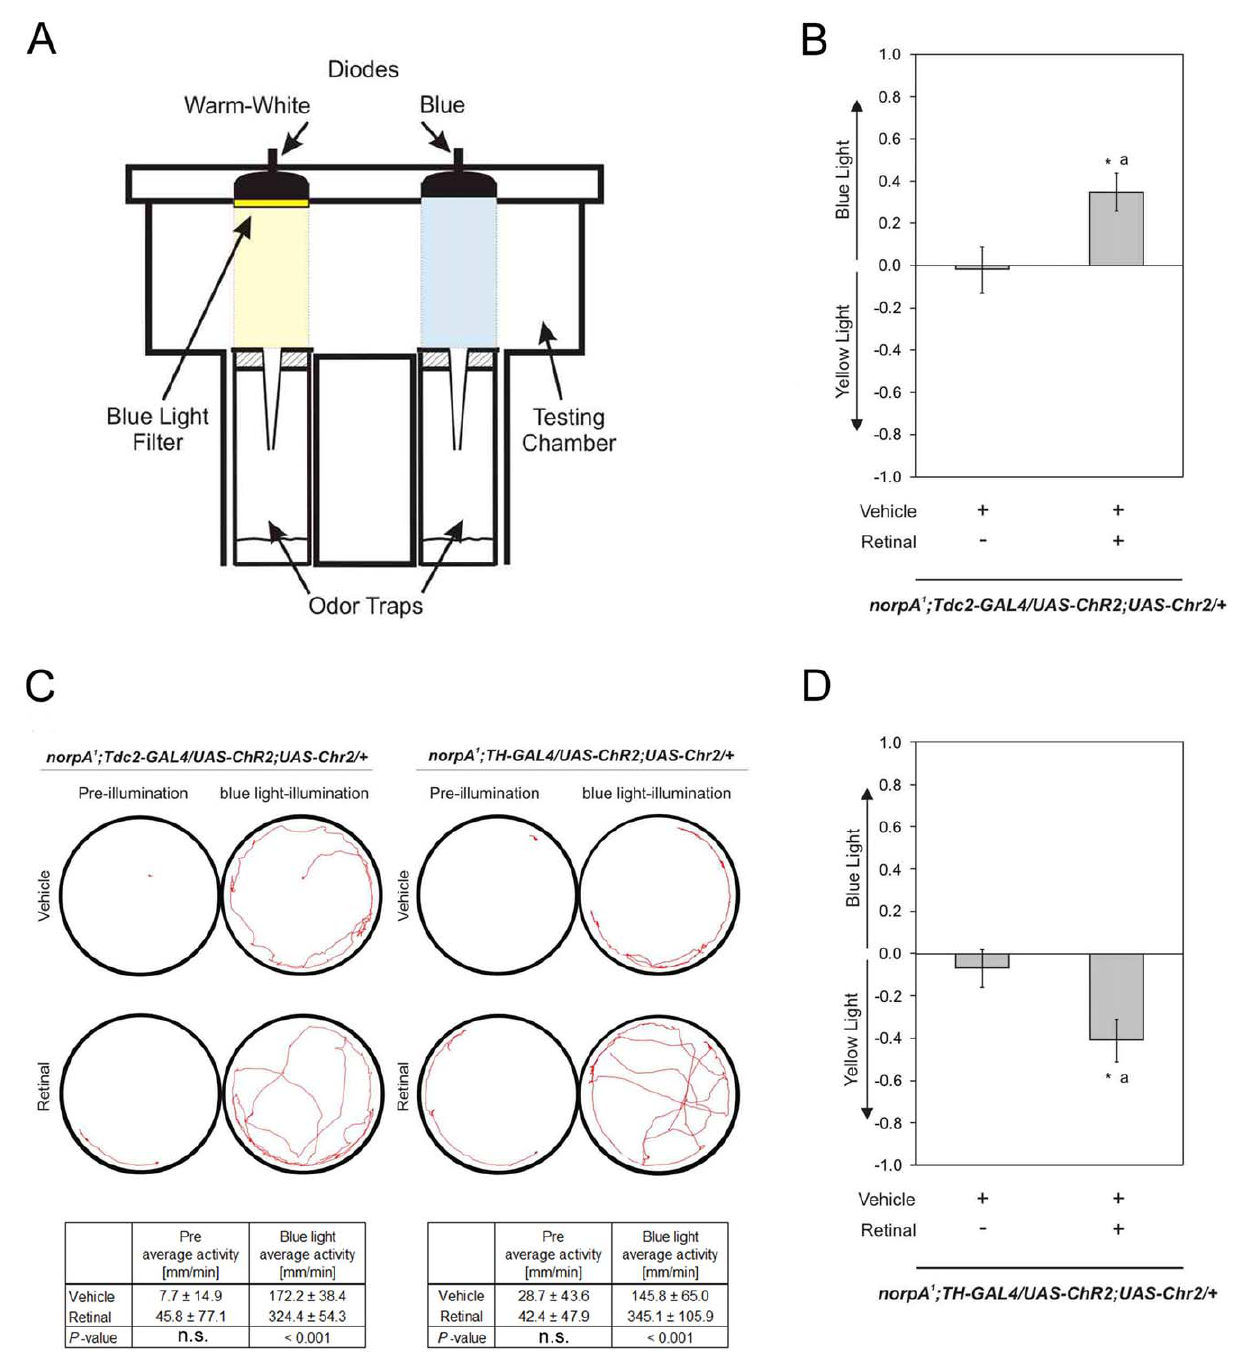
Figure 6. Neuronal activity is sufficient to induce preference. a The behavioral set up of the optogentic trap assay consists of two odor traps filled with food odor surrounded by a dark intransparent plastic. The assay is placed on a cold light plate to motivate flies to descend into the fly traps. On top of the two odor traps two different diodes – one for blue light and one for yellow – are placed that can be activated with the different frequencies. b Light activation of neurons in a Tdc2 -GAL4 dependent manner causes preference for the trap illuminated in blue (PIs are norp A1 , Tdc2 - GAL4/ UAS -ChR2; UAS -ChR2 with vehicle 2 0.02 6 0.11 and with retinal 0.35 6 0.09; n 12 for both. P , 0.05.). c Typical traces of norp A1 , Tdc2 -GAL4/ UAS - ChR2; UAS -ChR2 and norp A1 , TH -GAL4/ UAS -ChR2; UAS -ChR2 flies before and after a one min illumination period are shown. The average activity of 7 flies per genotype and condition are summarized in the table. d Activation of dopaminergic neurons causes aversion for the trap illuminated in blue (PIs are norp A1 , TH -GAL4/ UAS -ChR2; UAS -ChR2 with vehicle 2 0.07 6 0.09 and with retinal 2 0.41 6 0.1. n 20 and 35. P , 0.05.).